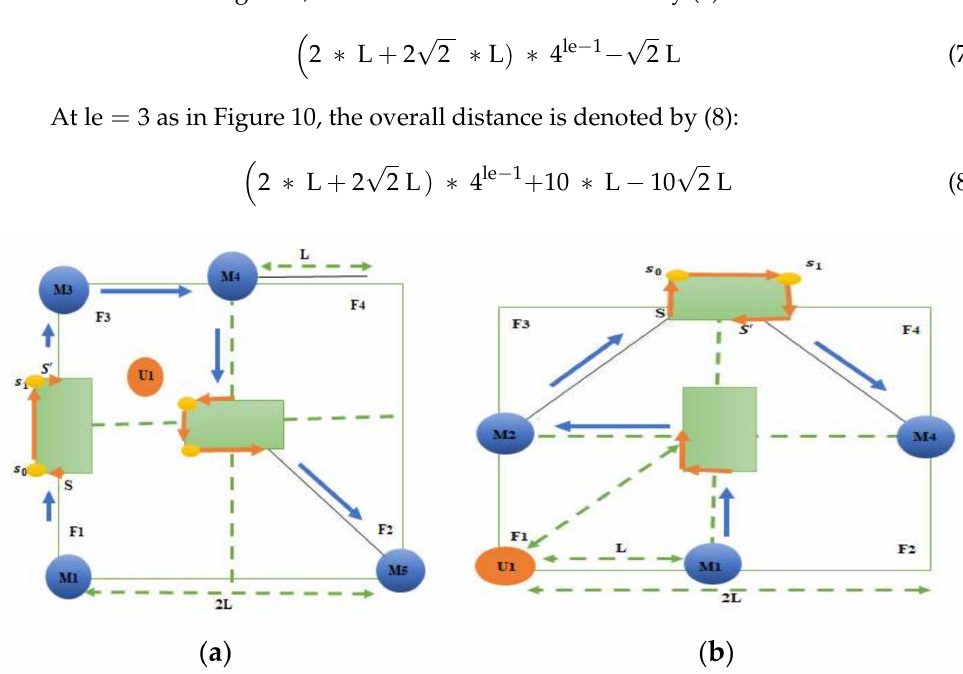
Figure 9. ( a ) R-Curve obstacle existence; ( b ) Arrow-Curve obstacle